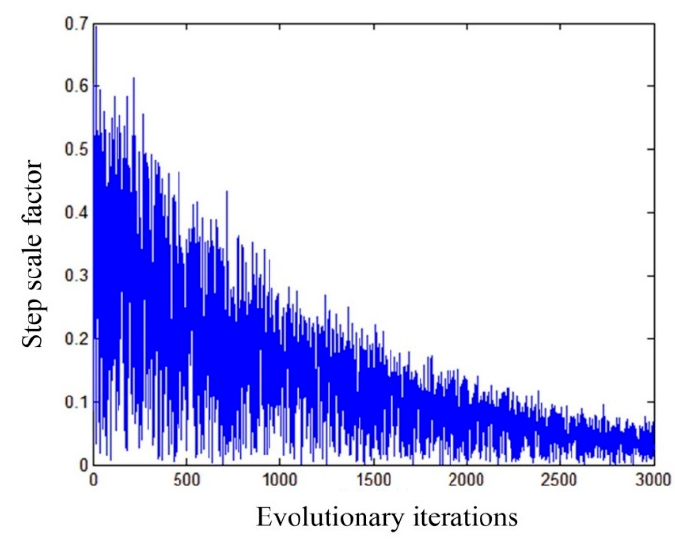
Figure 5. 𝛼 (cid:2868) (30 dimensions) in the evolution of ABCS algorithm. Figure 5. α 0 (30 dimensions) in the evolution of ABCS